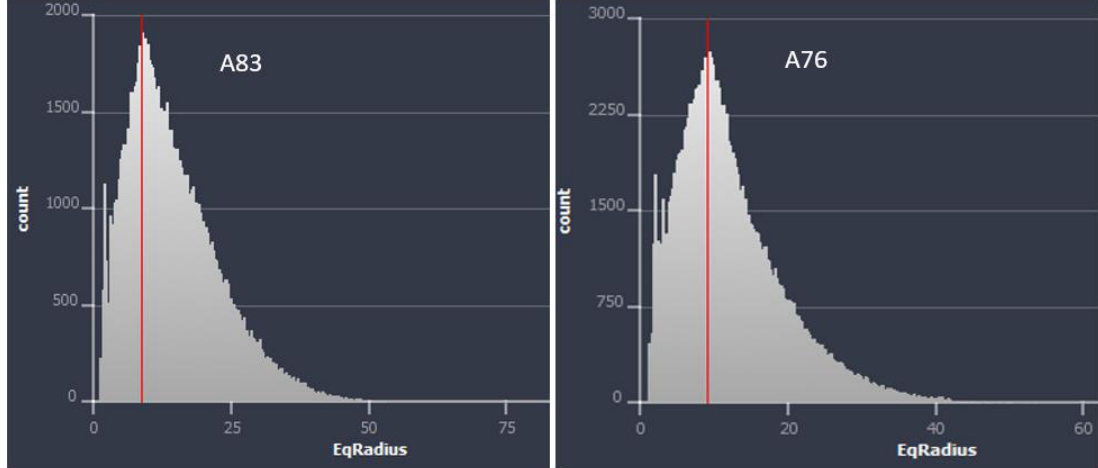
Figure 22. Pore throat size distribution in the range of 1–50 µ m. On the y-axis is the count (frequency) and the x-axis is the corresponding equivalent radii (EqRadius in µ m) of the pore throats.